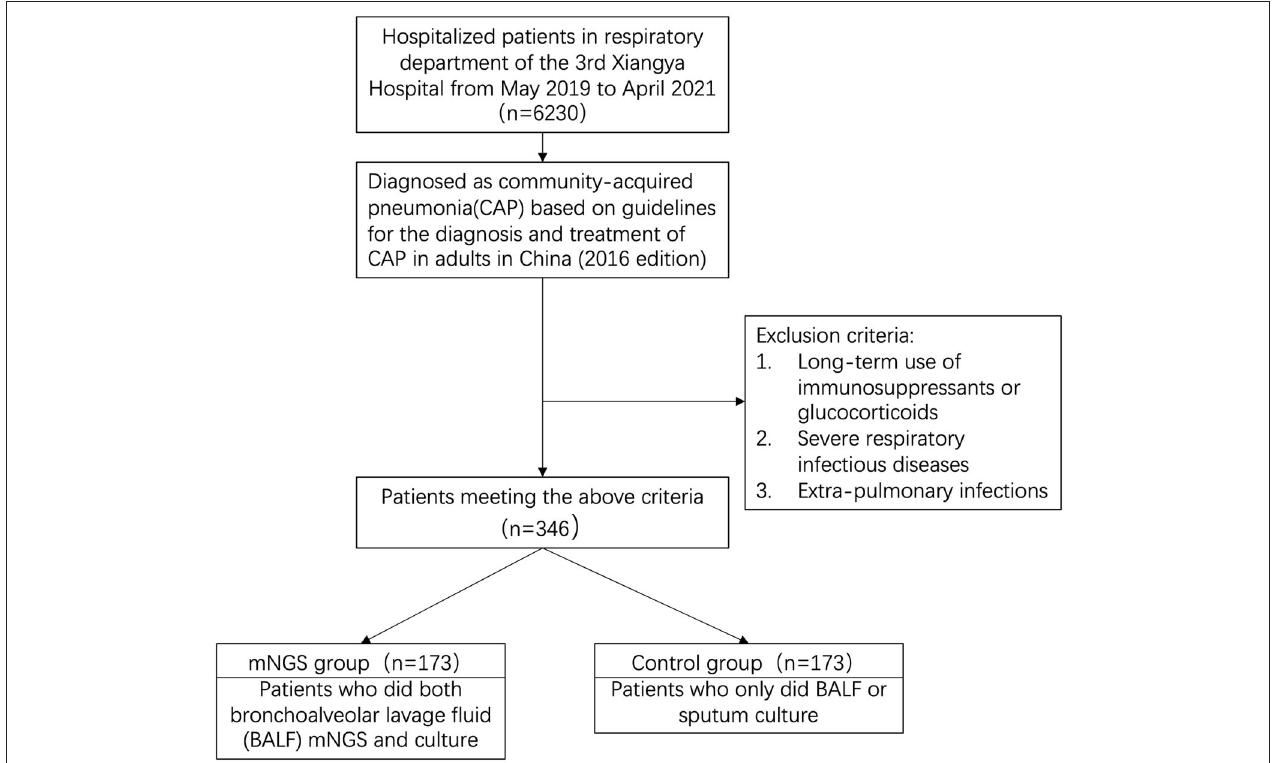
FIGURE 1 | Flowchart of case selection. From 6230 cases, a total of 370 community-acquired pneumonia cases were selected for further analysis. Patients in mNGS group did the mNGS and BALF culture at the same time. Patients in control group only did the BALF or sputum culture. mNGS, metagenomic next-generation